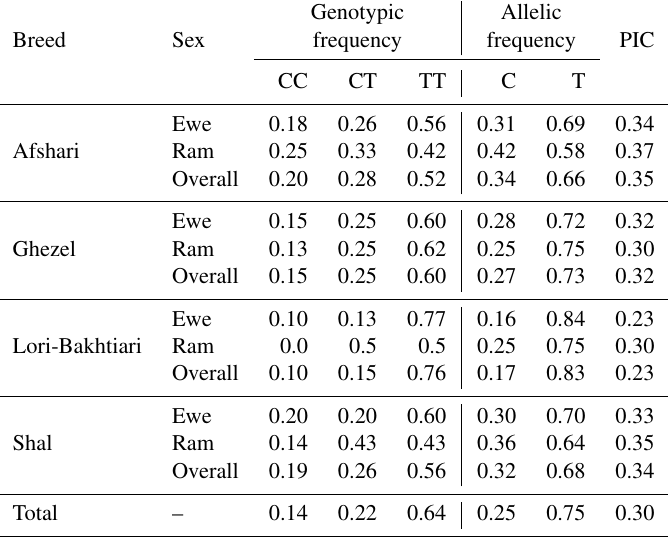
Table 3. Allelic and genotypic frequencies of the T750C mutation in Iranian Afshari, Ghezel, Lori-Bakhtiari, and Shal sheep breeds. Genotypic Allelic Breed Sex PICfrequency frequency CC CT TT C T Ewe 0.18 0.26 Afshari